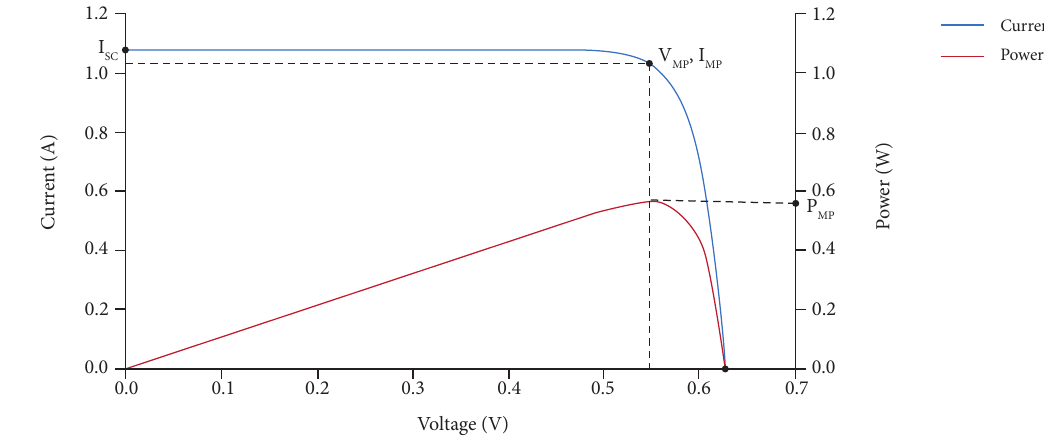
Figure 2. I-V Curve of a typical solar cell (Khurana et al.